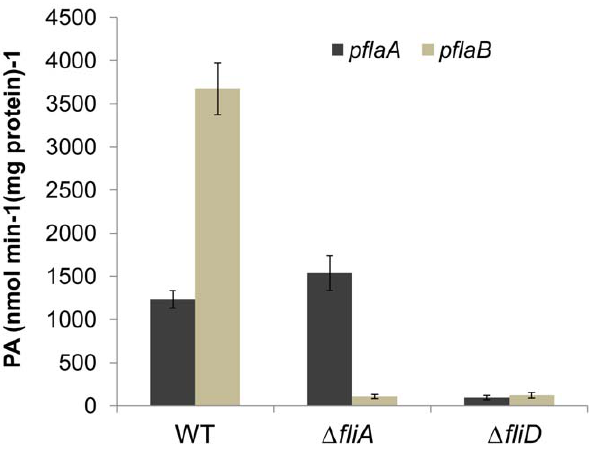
Figure 4. Promoter activities of flaA and flaB in S.oneidensis strains. Whole-cell lysates were prepared from S. oneidensis cultures in mid-exponential growth phase and assayed as described in Experi- mental Procedures. Promoter activities were determined by measuring b -galactosidase levels using flaA - lacZ and flaB - lacZ reporter constructs in the wild type, D fliA , and D fliD strains. Quantitation of the promoter activities was normalized to the total protein in each strain.